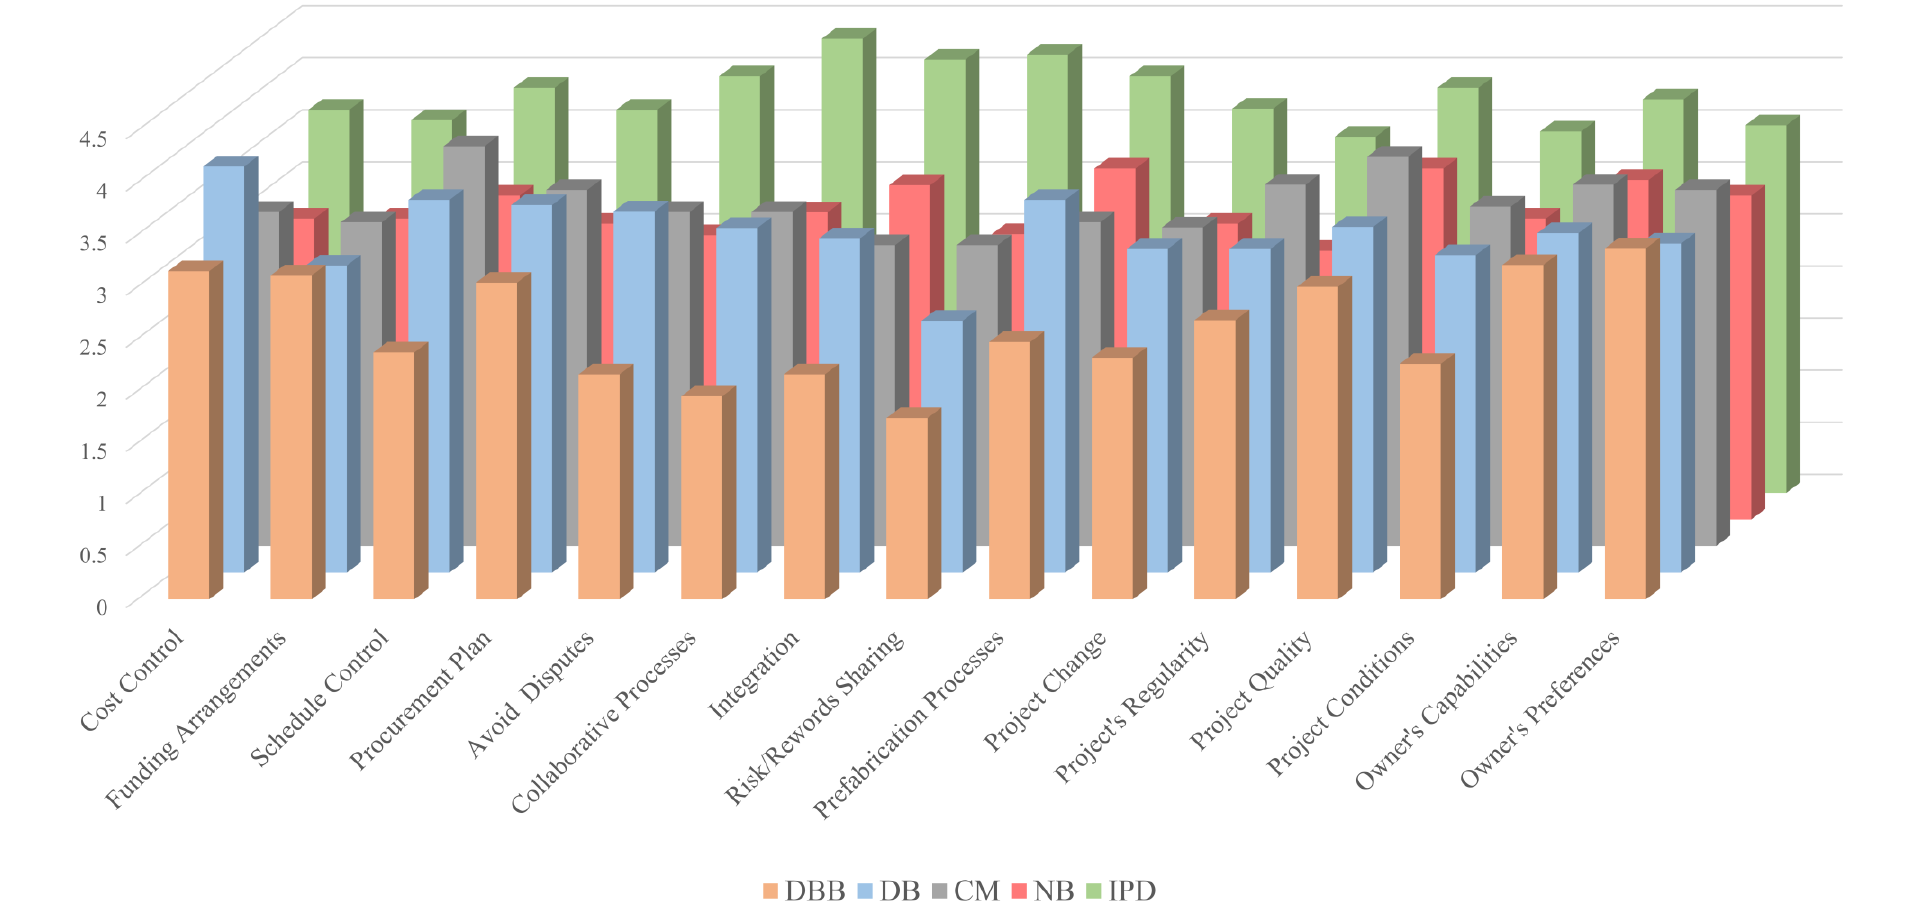
Figure 11. Average utilities for the Procurement methods according to individuals subcriteria .